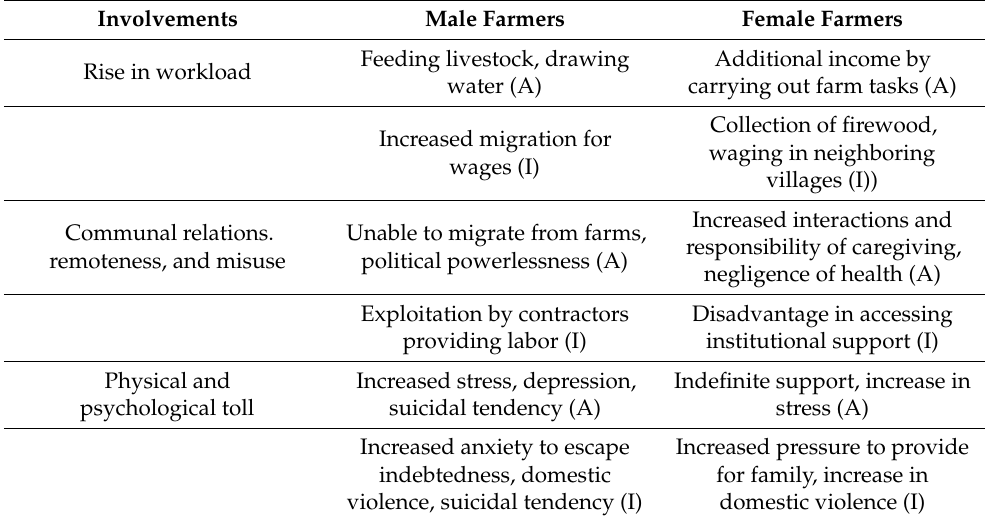
Table 1. Gender climate experiences. Source: IPCC,